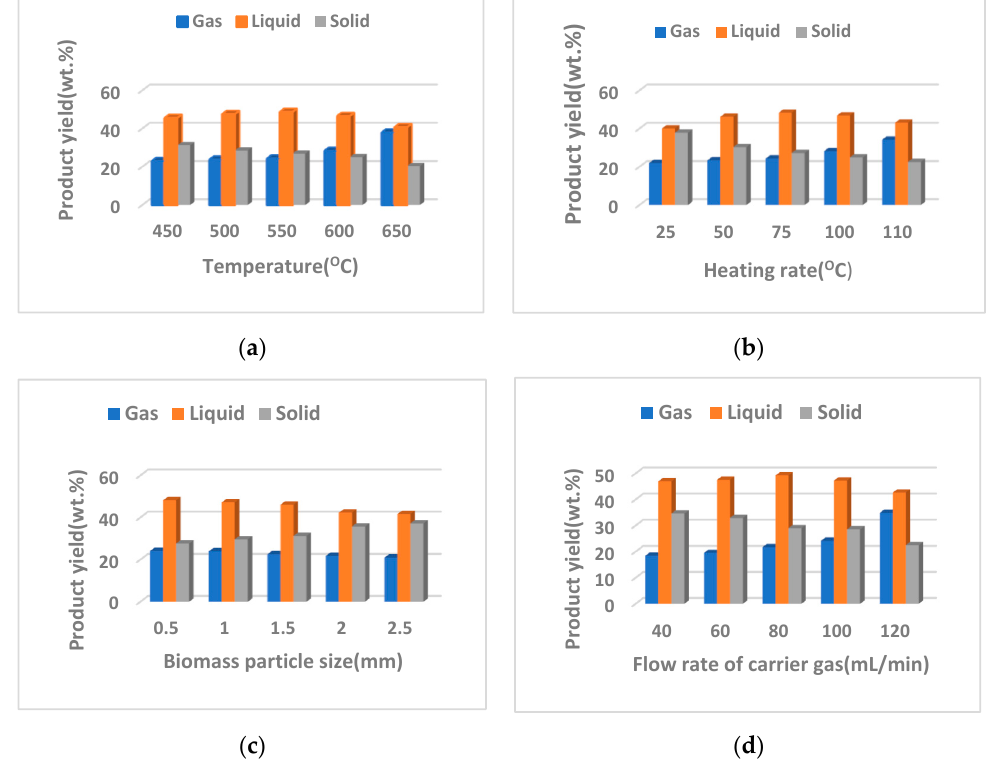
Figure 10. The product yield depending on the variation of the parameters of the pyrolysis process. The obtained results showed that a maximum liquid yield of 48.73 wt.% resulted at a pyrolysis temperature of 550 °C, which indicates that, at this temperature, the pyrolysis process was complete and led to the formation of a larger amount of condensable volatile compounds. On the other hand, it was observed that, at a lower pyrolysis temperature (450 or 500°C), the char yield was higher (31.29 wt.% and 28.55 wt.% for 450 °C and 500 °C, respectively), while the gas yield changed very little (23.06 and 23.81 wt.% for 450 °C and 500 °C, respectively), but the liquid fraction increased from 45.64 to 47.63 wt.% for a